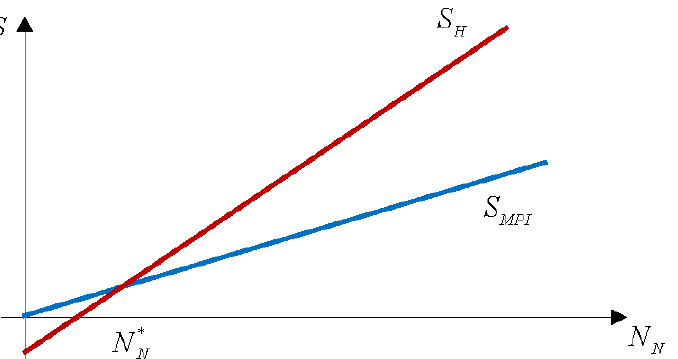
Figure 2. Upper bound for the speed-up parameter as a function of number of nodes N N : pure MPI approach ( S MPI ) and hybrid OpenMP–MPI approach ( S H ).